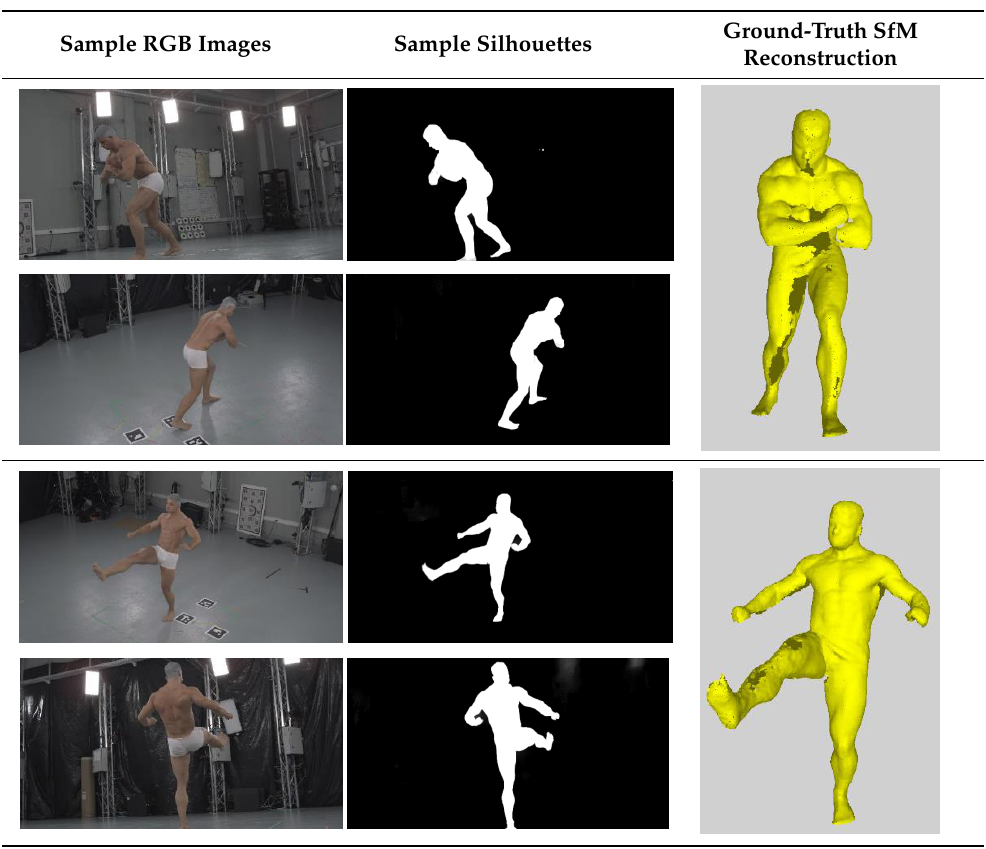
Table 2. Sample test poses (2 out of the total of 20) used to validate the sSfS algorithm with corresponding RGB images, estimated silhouettes for 2 chosen cameras out of the set of 34, and photogrammetric reconstruction.